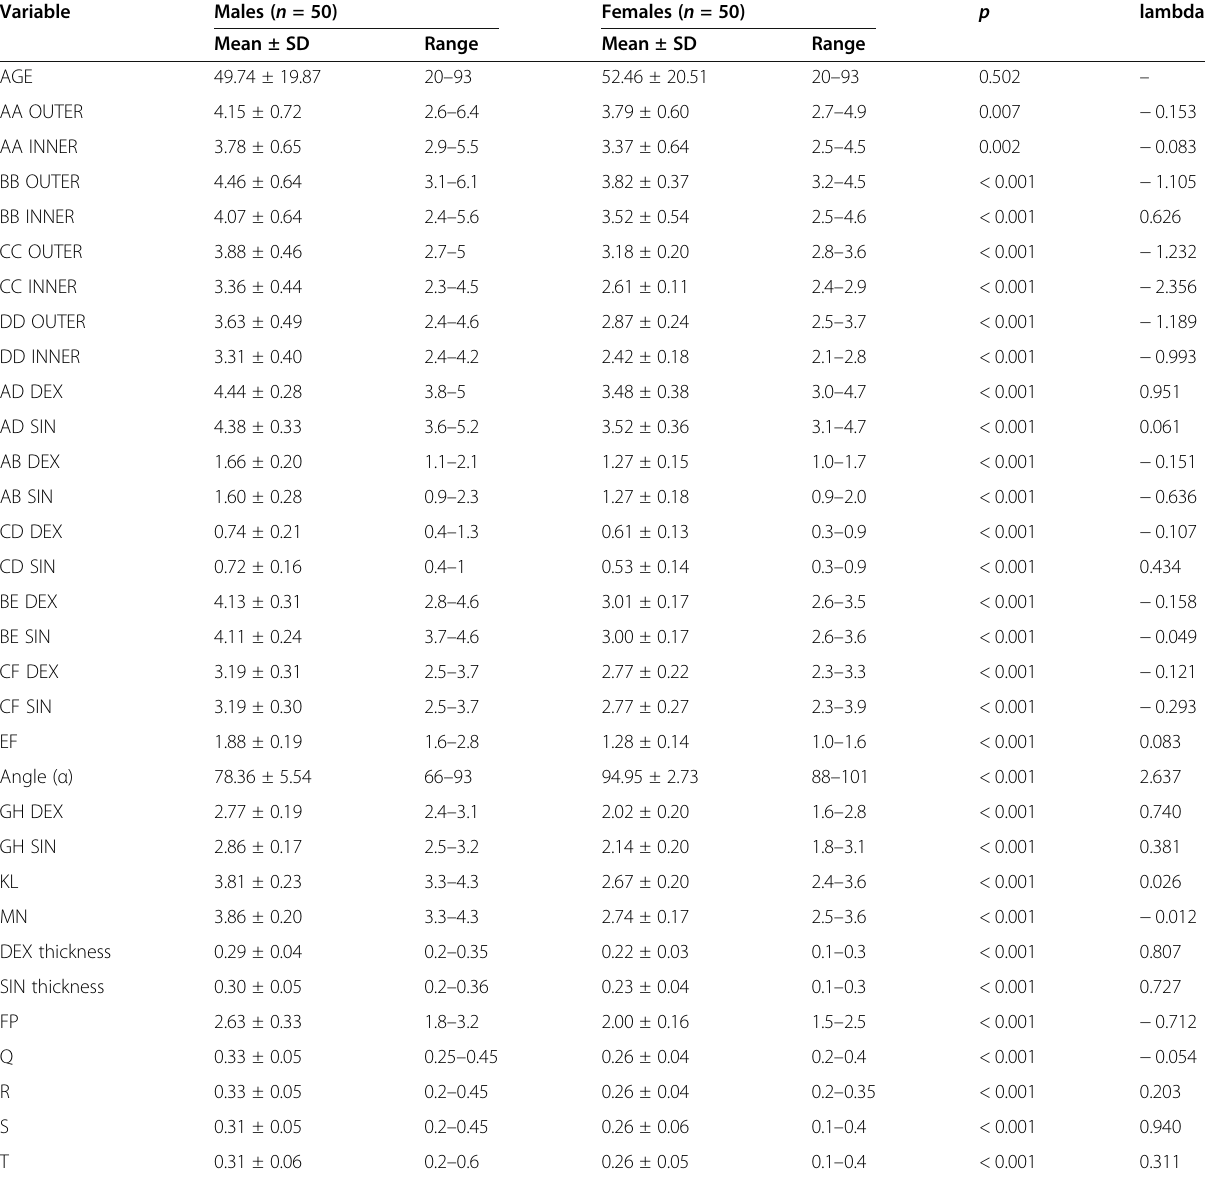
Table 4 Description of the variables collected. P indicates the significance of differences in variables in the two groups based on the test of equality of group averages; lambda indicates parameters for Box-Cox